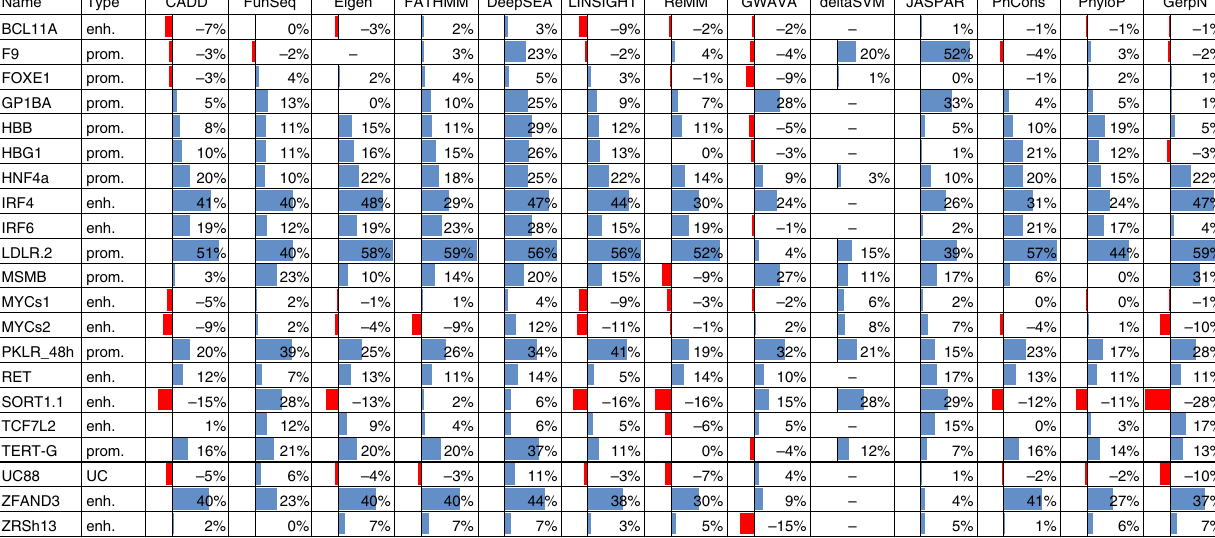
Fig. 5 Spearman correlation of computational scores with measured expression effects. The fi gure reports Spearman correlation coef fi cients (in percent) of the absolute expression effect for all SNVs with at least ten tags in each region with various measures agnostic to the cell type, like conservation (mammalian PhyloP, mammalian PhastCons, and GERP ++ ), overlapping TFBS as predicted in JASPAR 2018 (counting those in the top 10th percentile of motif scores across all elements, all motifs, and additional percentiles are available in Supplementary Table 15), and computational tools that integrate large sets of functional genomics data in combined scores (CADD v1.4, DeepSEA, Eigen, FATHMM-MKL, FunSeq2, GWAVA region model, LINSIGHT, and ReMM). In addition, we compared a subset of experiments (10/21) to absolute deltaSVM scores available for speci fi c cell types (HEK293T, HeLa S3, HepG2, K562, and LNCaP). In cases where an annotation is based on positions rather than alleles, we assumed the same value for all substitutions at